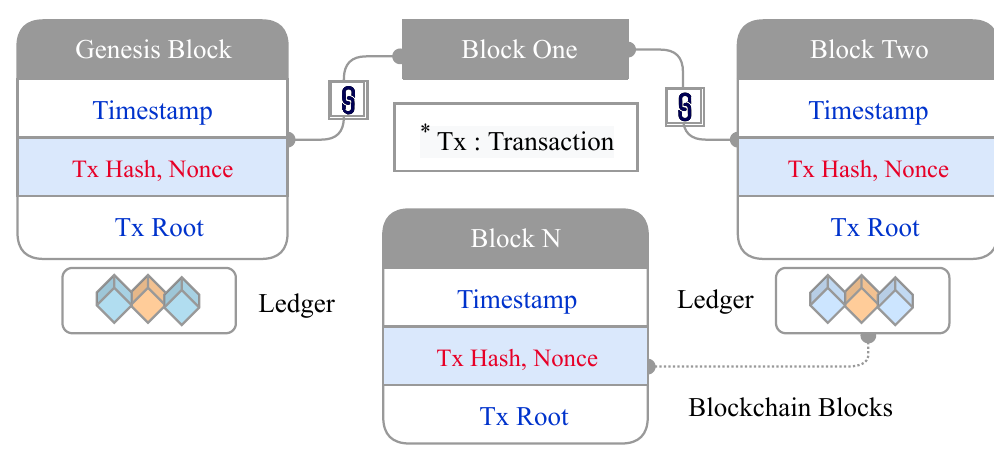
Figure 1. Overview of different blocks with timestamp, hash, nonce, and transaction data.